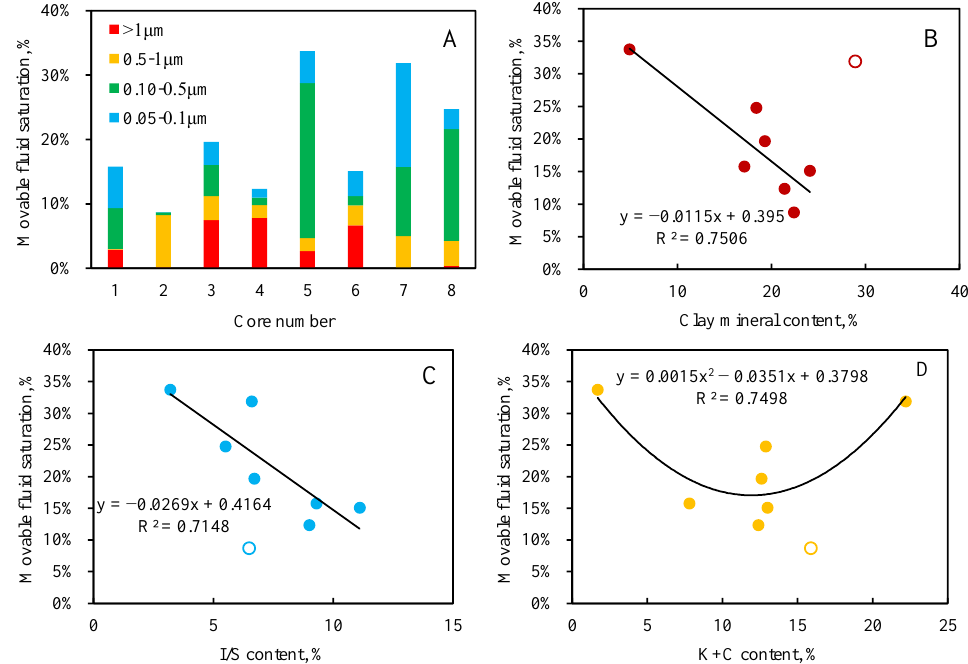
Figure 13. Correlation between the movable fluid saturation distribution and the clay mineral content: ( A ) Movable fluid saturation distribution; ( B ) movable fluid saturation vs. clay mineral content; ( C ) movable fluid saturation vs. I/S content; and ( D ) movable fluid saturation vs. K + C content.